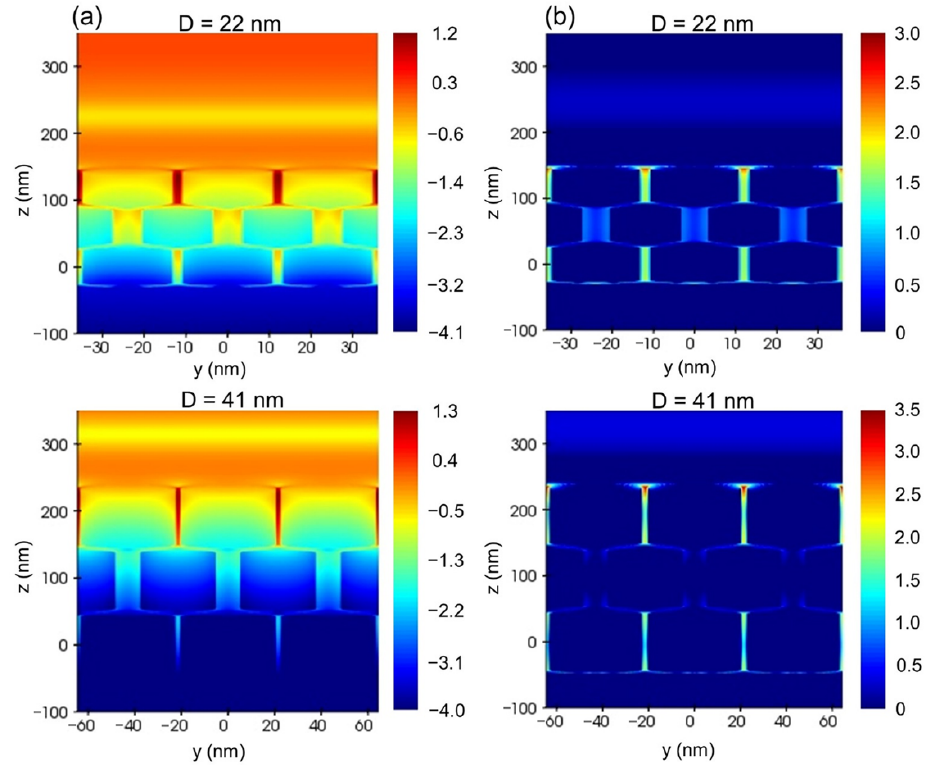
Figure 7. Simulated near-field | E / E 0 | 2 distributions of vertical Au nanorod arrays with the diame- ters of 22 and 41 nm at the logarithmic scale: ( a ) harmonic wavelength (400 nm); ( b ) fundamental wavelength (800 nm).